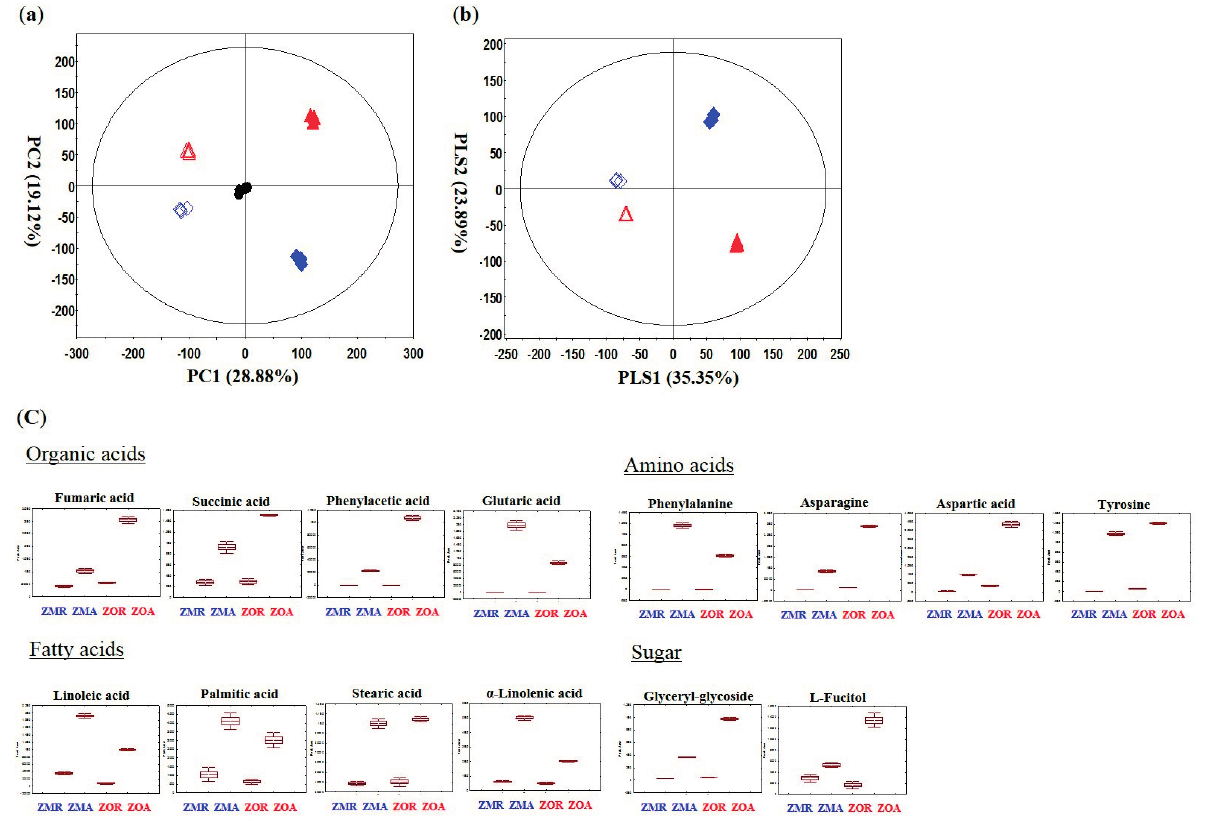
Figure 1. Principal component analysis score plot (PCA) ( a ), Partial least-squares discriminant analysis (PLS-DA) ( b ), and box whisker plots ( c ) of Z. officinale and Z . mioga with different structural parts analyzed by GC-TOF-MS. ▲ : ZMR ( Zingiber mioga Thunb. Root part), △ : ZMA ( Zingiber mioga Thunb. Aboveground part), ♦ : ZOR ( Zinger Officinale Thunb . Root part), ◊ : ZOA ( Zingiber Officinale Thunb. Aboveground part), and ● : Quality